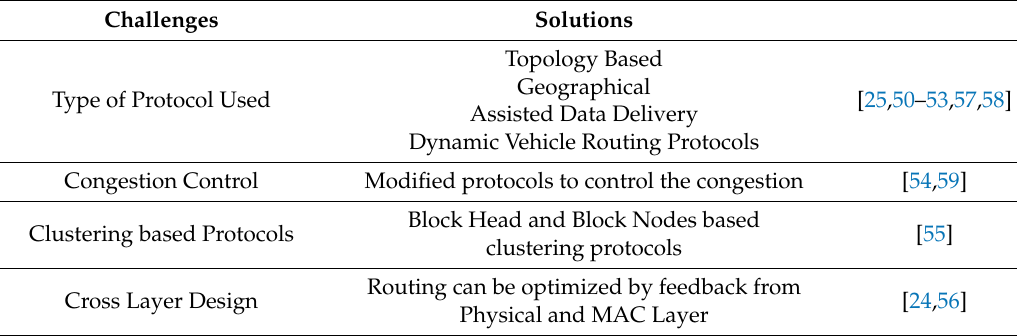
Table 4. Routing